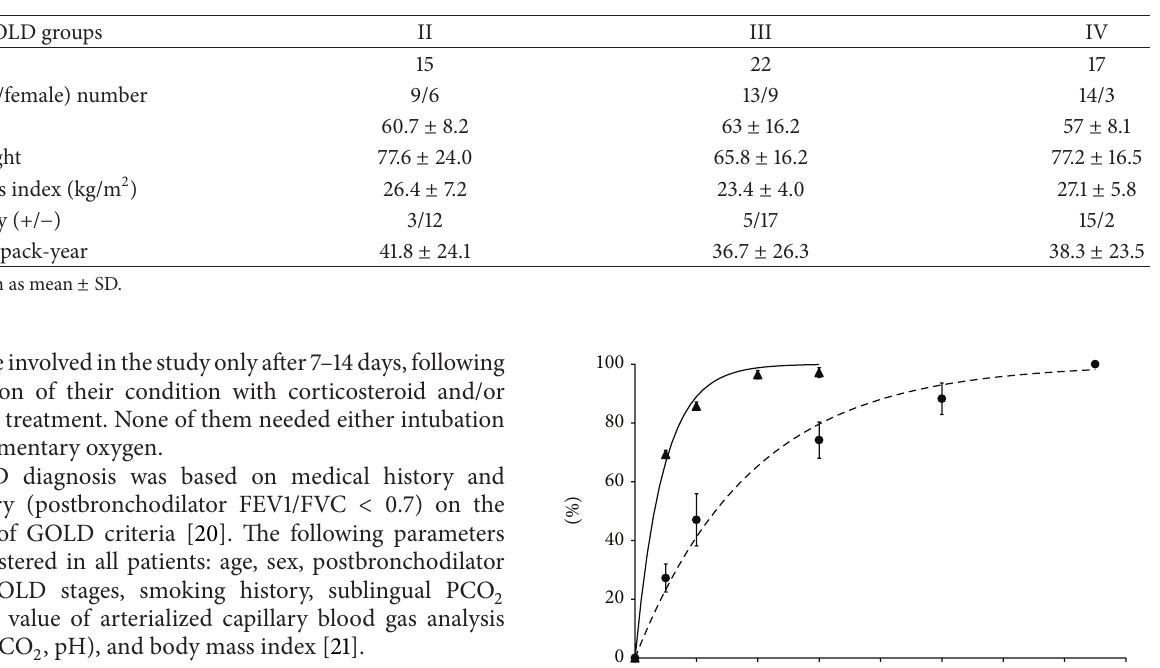
Table 1: Clinical data of the study population.